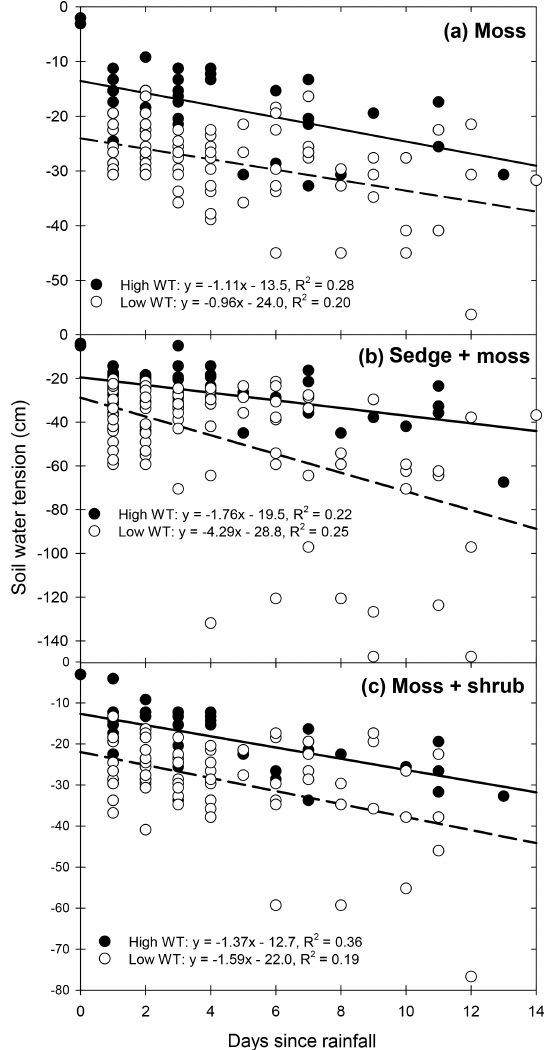
Figure 3. Relationship between daily soil water tension (centime- tre of water) and days since the last rainfall/irrigation event for (a) moss, (b) sedge + moss, and (c) moss + shrub monoliths. Data for each vegetation type are separated between high WT and low WT portions of the experiment. Data are combined between precip- itation frequency treatments. Linear regressions are provided. All regressions were significant ( p < 0 .